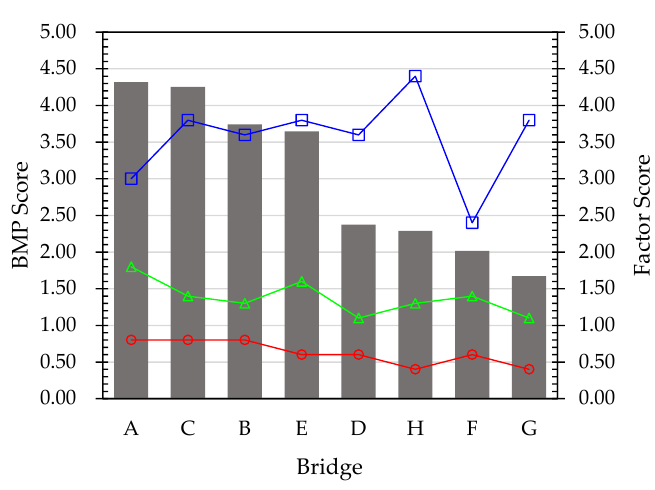
Figure 6. Results by maintenance priority.